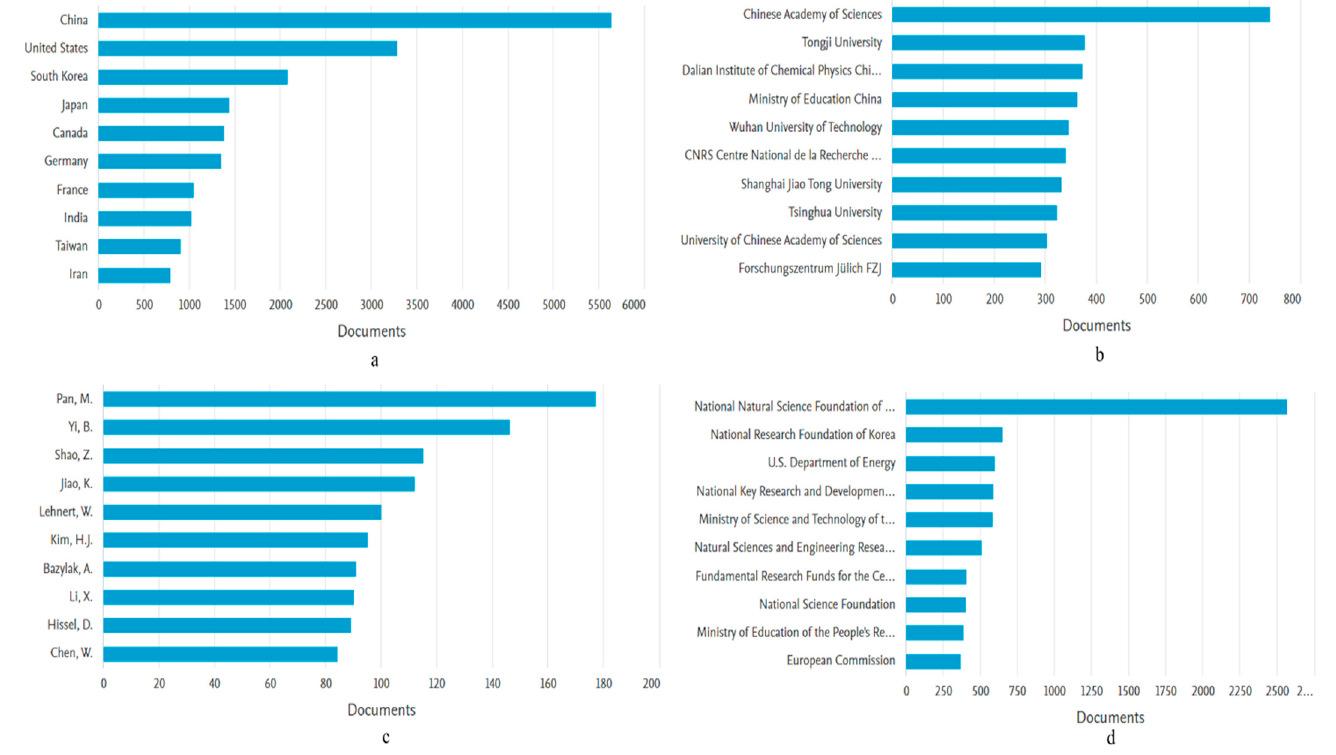
Figure 15. Top performing PEMFC research agents from 2000 to 2021 (( a ): countries/regions, ( b ): affiliations, ( c ): authors, ( d ): funding agencies).